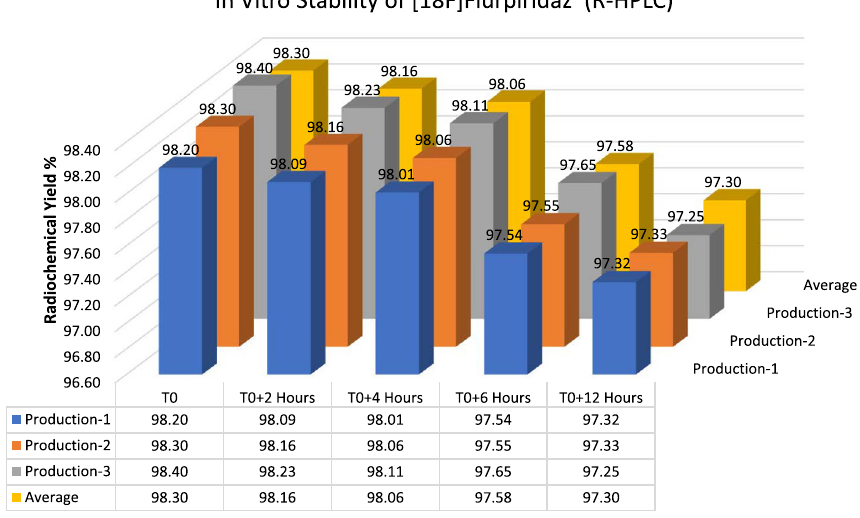
Fig. 8 Stability studies of [ 18 F]Flurpiridaz ( 7 ) (T0